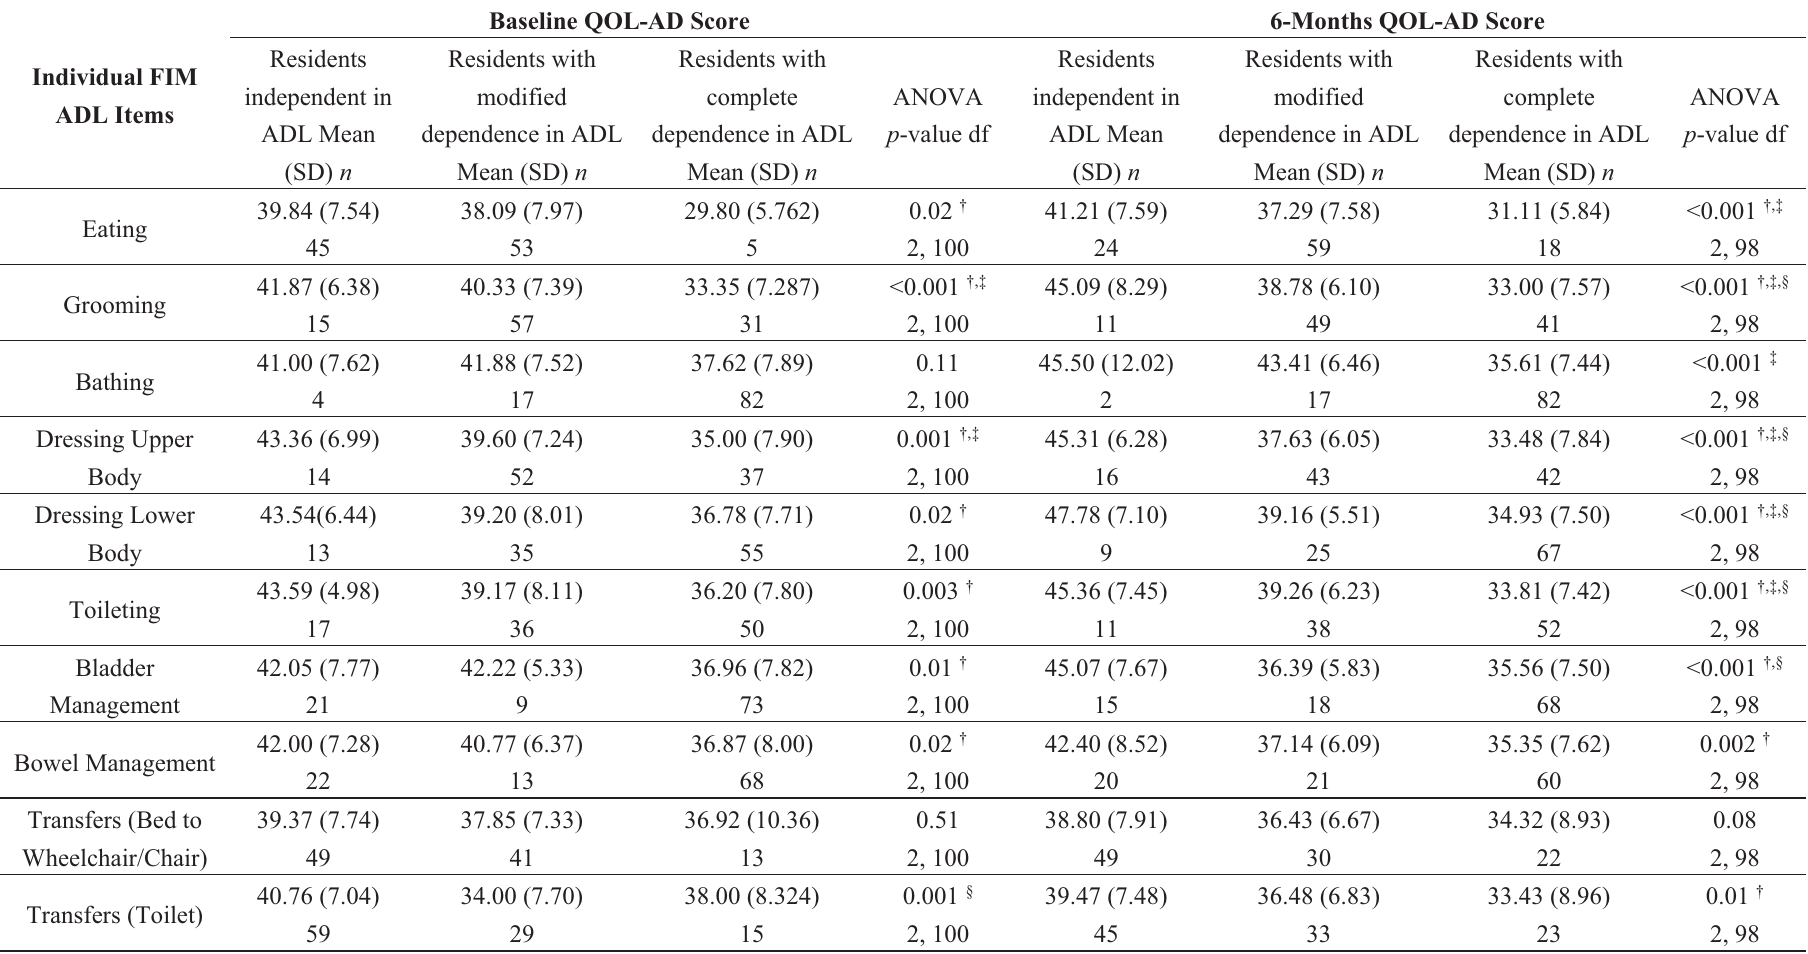
Table 3. QOL-AD mean scores across three levels of dependency for each FIM